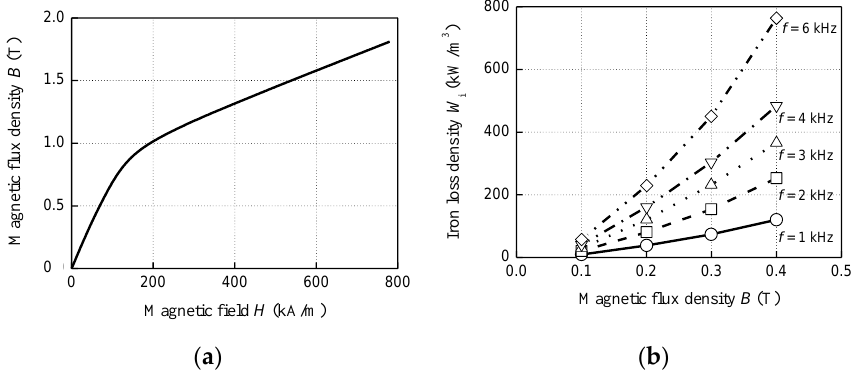
Figure 3. Magnetic characteristics of magnetic composite ring: ( a ) static magnetization and ( b ) iron loss.